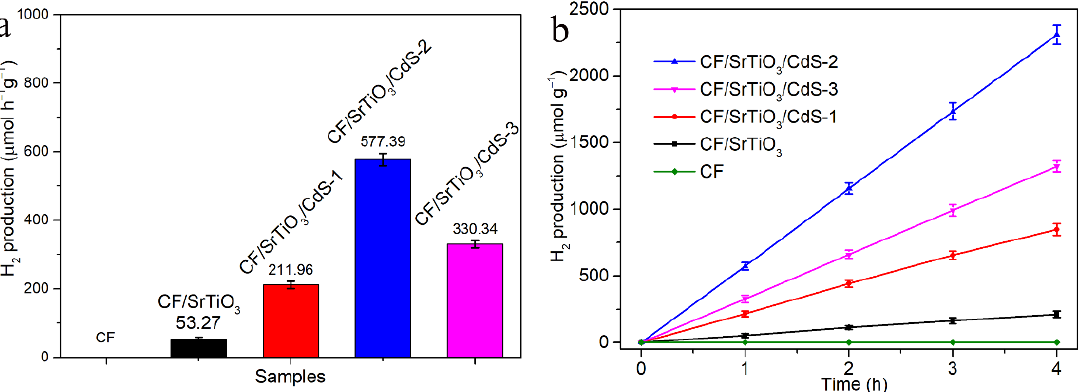
Figure 8. Photocatalytic hydrogen production rates ( a ) and time-dependent hydrogen production amounts ( b ) of different samples.